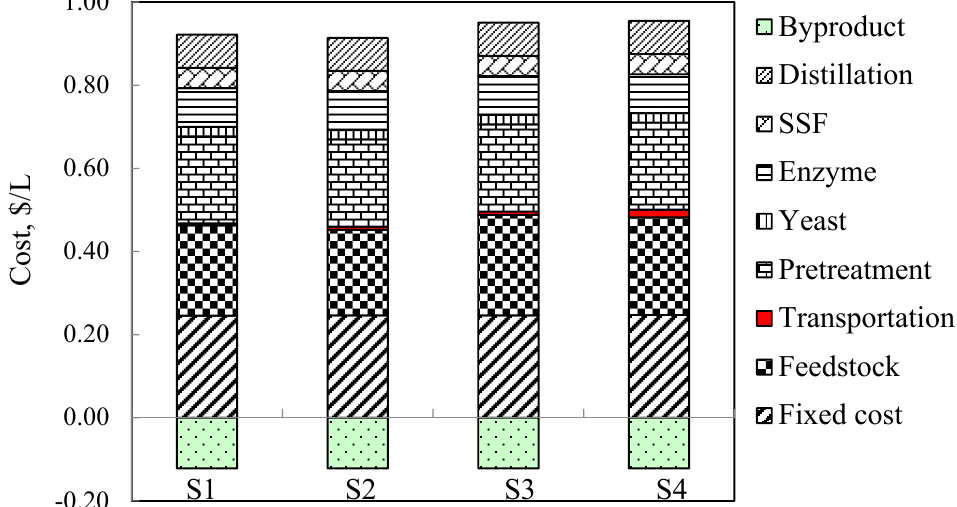
Figure 6. Cost breakdown of the LC of ethanol (Southern